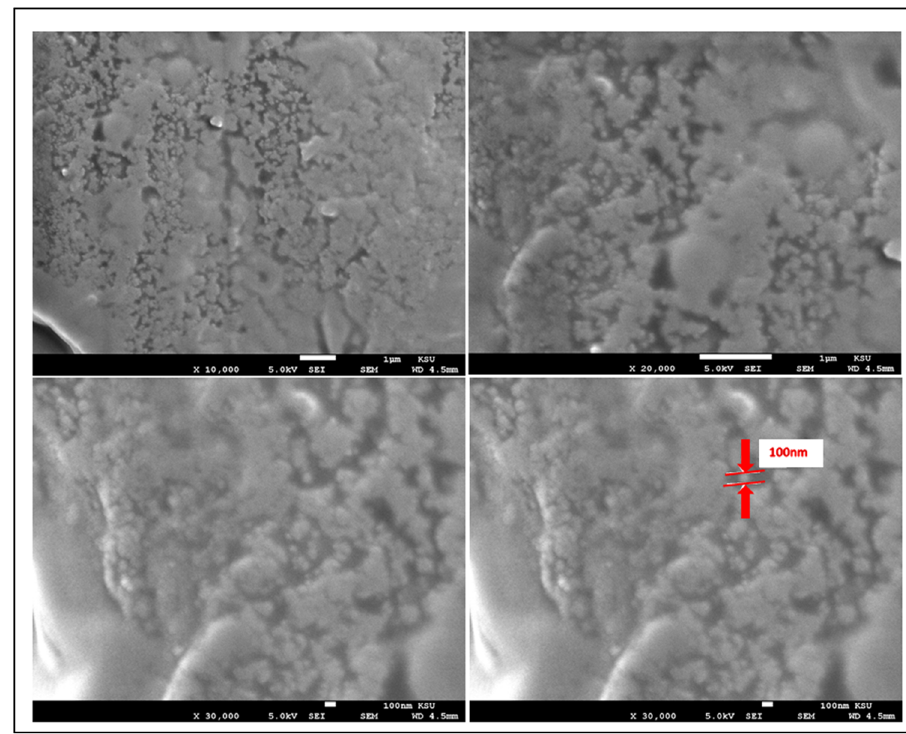
Figure 4: SEM of hydrogel fi lm